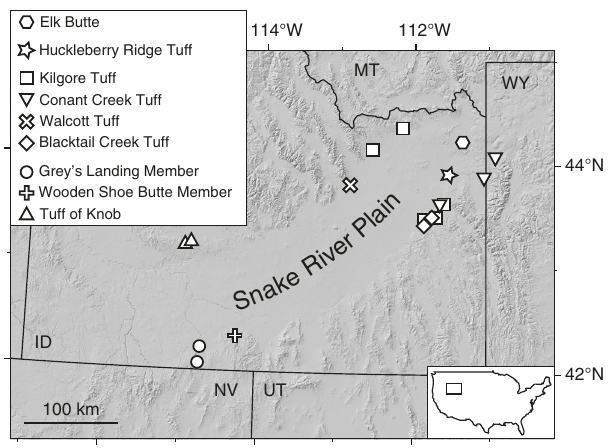
Fig. 2 Digital elevation map of the Snake River Plain area and sampling locations of analysed rhyolites. ID Idaho, MT Montana, WY Wyoming, NV Nevada, UT Utah. Base map is a processed NASA Shuttle Radar Topography Mission (SRTM) v4.1 90 m digital elevation model (DEM)